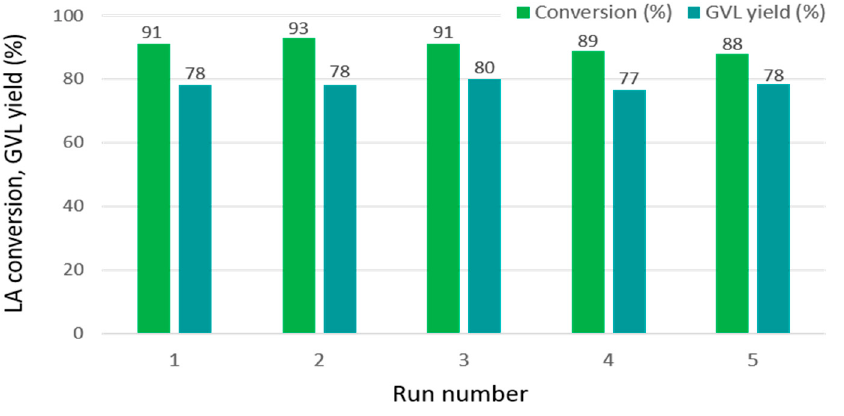
Figure 9. Reusability tests on the Ru@TiO 2 -SiO 2 3:3-ns catalyst. Reaction conditions: 0.66 g LA (5.68 mmol), 77.6 mg supported catalyst (0.019 mmol Ru), 50 bar H 2 , 20 mL H 2 O, temperature 323 K, and reaction time 20 min.